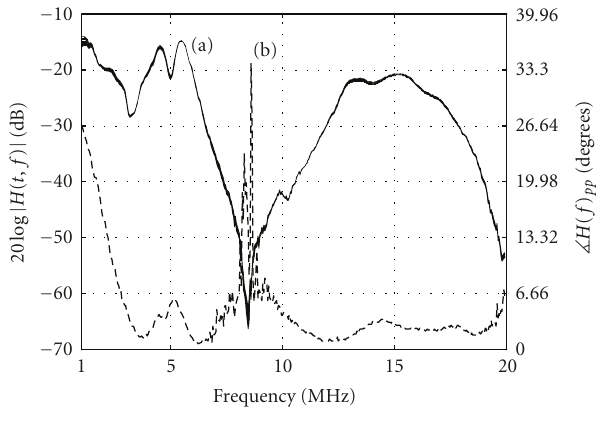
Figure 1: (a) Superimposed values of the amplitude channel response along the mains cycle. (b) Peak excursion of the channel phase response along the mains